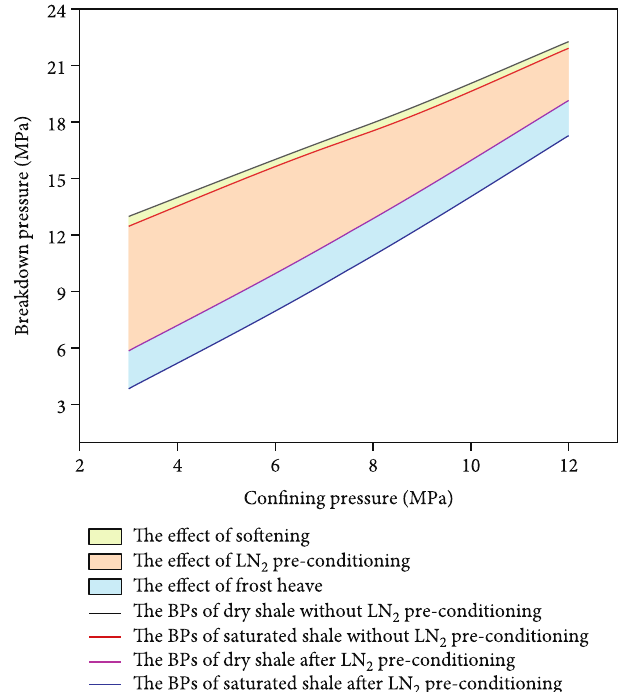
Figure 13: Average breakdown pressure of dry and saturated parallel bedding shales under di ff erent con fi ning